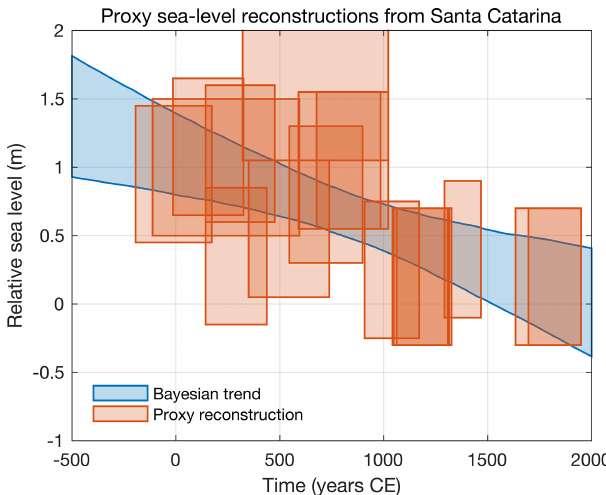
Figure 5. Proxy sea-level reconstructions (orange) and Bayesian linear regression (blue). Orange shading identifies best estimates plus and minus twice the standard errors. Blue shading corresponds to 95% posterior credible intervals. The Bayesian model is detailed in the